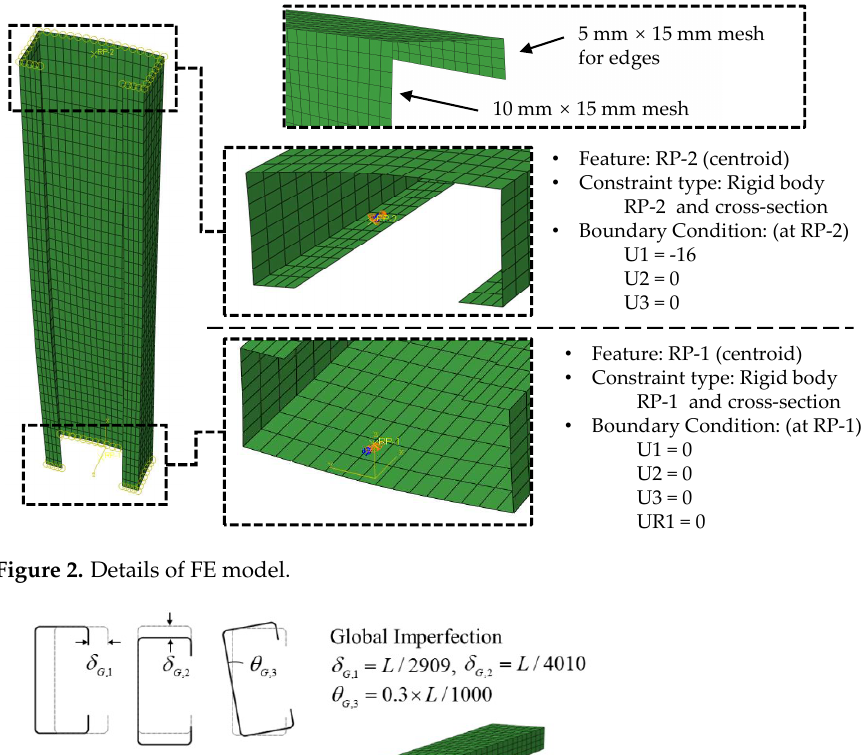
Figure 1. Constitutive model and test coupon [48].